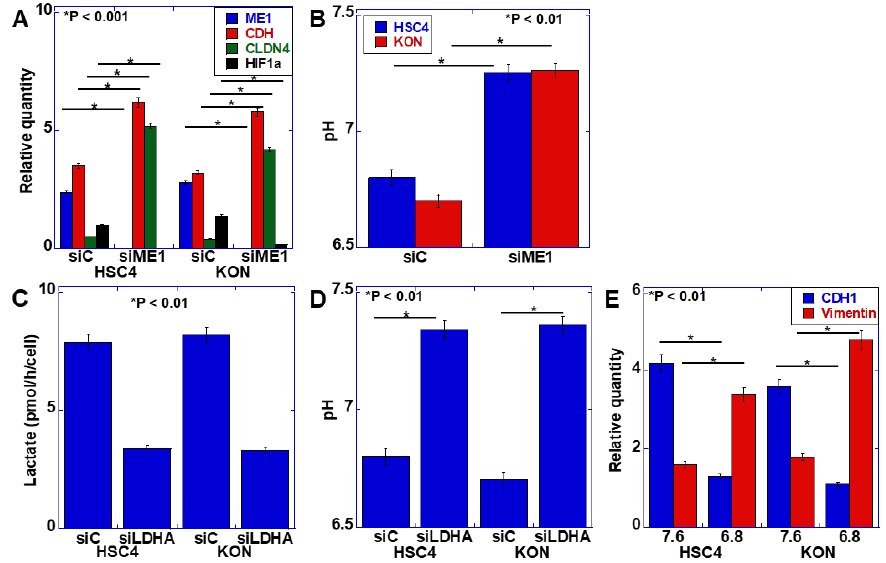
Figure 2. Effect of extracellular pH on the epithelial–mesenchymal transition (EMT) phenotype in HSC4 and KON oral squamous cell carcinoma (OSCC) cells. ( A , B ) Effect of the knockdown of ME1 on mRNA expression of EMT-associated genes measured by quantitative PCR ( A ) and extracellular pH ( B ) in HSC4 and KON cells. ( C , D ) Effect of the knockdown of lactate dehydrogenase A (LDHA) on extracellular lactate concentration ( C ) and pH ( D ) in HSC4 and KON cells. ( E ) Effect of medium pH on the EMT phenotype in HSC4 and KON cells. Expression was measured by quantitative PCR. Error bar, standard deviation tested by Student’s t -test in three independent trials. CDH, E-cadherin; CLDN, claudin; HIF, hypoxia-inducible factor; siRNA, small interference RNA; siME, siRNA for ME1; siC, control siRNA; siLDHA, siRNA for LDHA. 2.3. Relationship between the Warburg effect and Lactate Secretion EMT was induced by the acidification of the extracellular pH, suggesting that the transition promoted by ME1 from oxidative phosphorylation of energy production to glycolysis and lactate fermentation is important for EMT acquisition. Therefore, we next knocked down pyruvate dehydrogenase (PDH), which induces oxidative phosphorylation through metabolism of pyruvate, the final metabolite of glycolysis, or inhibited PDH kinase, which induces glycolysis by dichloroacetate (DCA) (Figure 3A–C). Knockdown of PDH increased lactate production and decreased the extracellular pH (Figure 3A). In contrast, inhibition of PDH kinase decreased lactate production and increased the extracellular pH (Figure 3B). On examining the expression of CLDN4 and HIF1α, which are involved in the EMT phenotype (Figure 3C), CLDN4 expression was found to be decreased, and HIF1α expression was enhanced by PDH knockdown, indicating promotion of the EMT phenotype. In contrast, inhibition of PDH kinase increased CLDN4 expression and decreased HIF1α expression, indicating suppression of the EMT phenotype. Next, to confirm the significance of lactate secretion compared with the increase in intracellular lactate levels, the monocarbonate transporter (MCT)-1, which promotes secretion of lactate extracellularly, was knocked down. (Figure 3D–F). As a consequence, the extracellular lactate level was found to decrease, and the extracellular pH increased. At this time, CLDN4 expression increased, and HIF1α expression decreased, indicating suppression of the EMT phenotype. As observed above, the decrease in extracellular pH due to the increase in lactate secretion accompanying the enhancement of the Warburg effect induced the EMT phenotype.